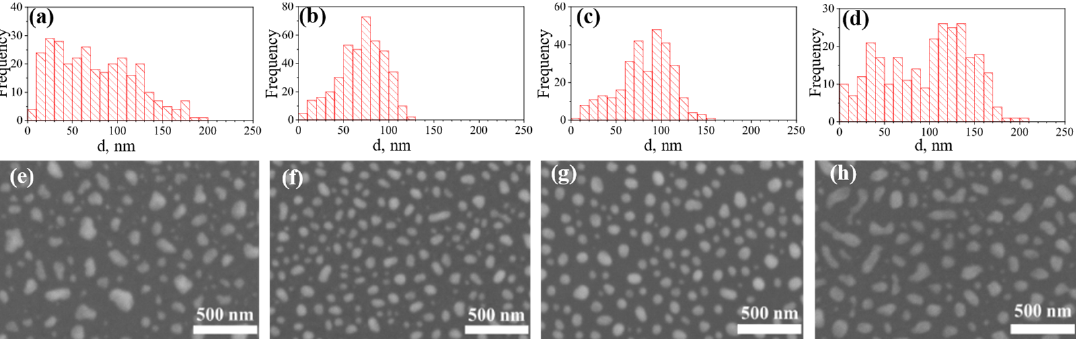
Figure 1. The diameter ( d ) distribution of AgNPs on the TiO 2 surface and SEM images of AgNP/TiO 2 structures obtained by SSD process ( t a = 60 min, h Ag = 10 nm) at different T a : ( a , e ) 300 °C; ( b , f ) 350 °C; ( c , g ) 400 °C; ( d , h ) 450 °C.